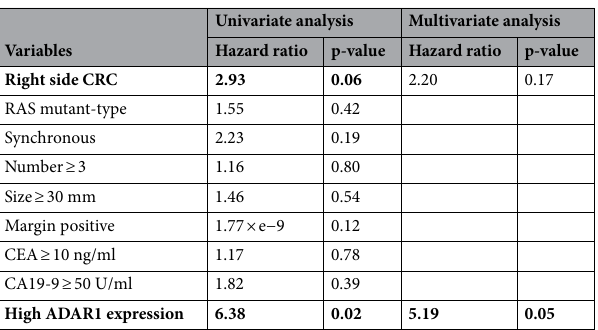
Table 3. Univariate and multivariate analyses of remnant liver recurrence. Significant values are in bold.